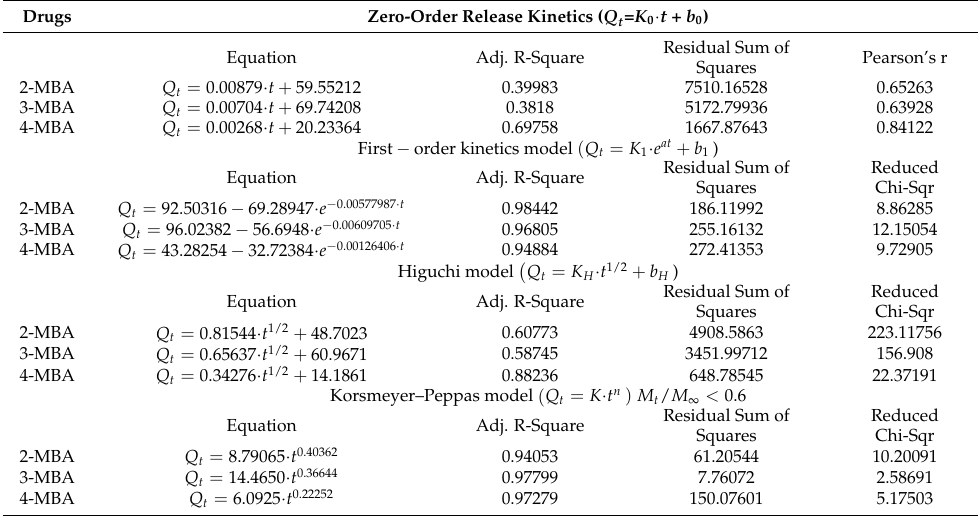
Table 3. The release kinetics model fitting parameters of 2-MBA, 3-MBA, and 4-MBA